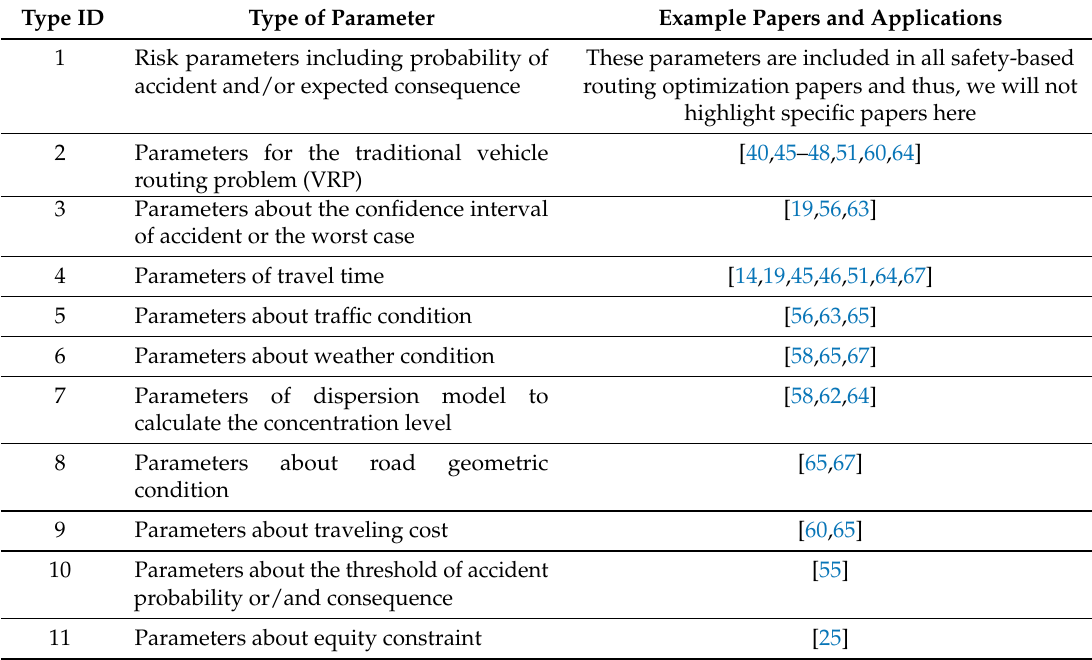
Table 3. Type of input parameters included within trucking safety oriented optimization